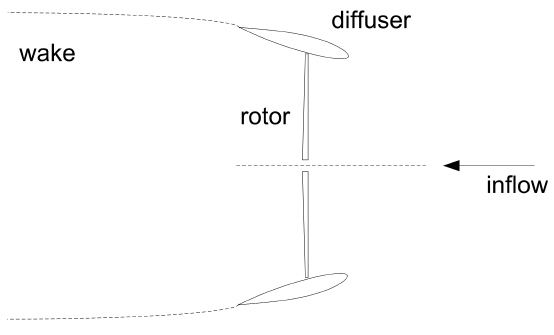
Figure 10. Shrouded rotor concept. The diffuser enables a flow acceleration, increasing the performance of the